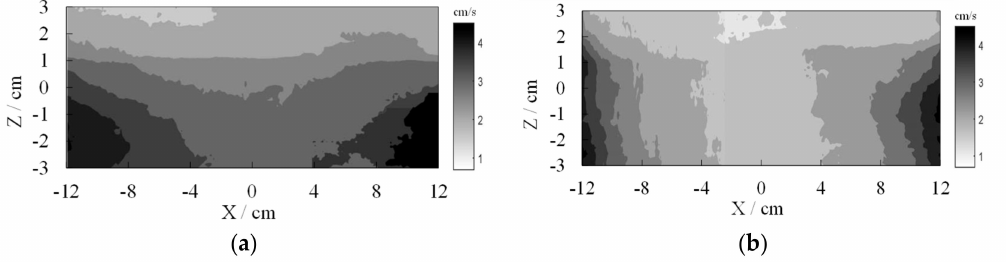
Figure 7. The RMS velocity when s = 0.5 cm and f = 3 Hz: ( a ) u component; ( b ) w component.